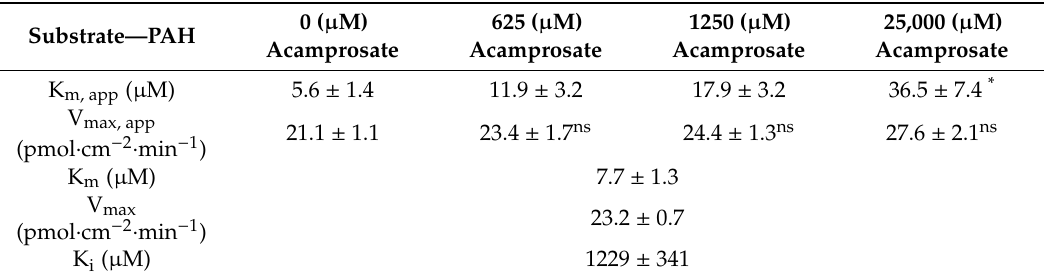
Table 3. Kinetic parameters associated with the uptake of p -aminohippuric acid (PAH) in the presence of various acamprosate concentrations in OAT1 expressing HEK293 cells. Data are reported as mean ± SEM of replicates in three cell passages obtained at Lab.